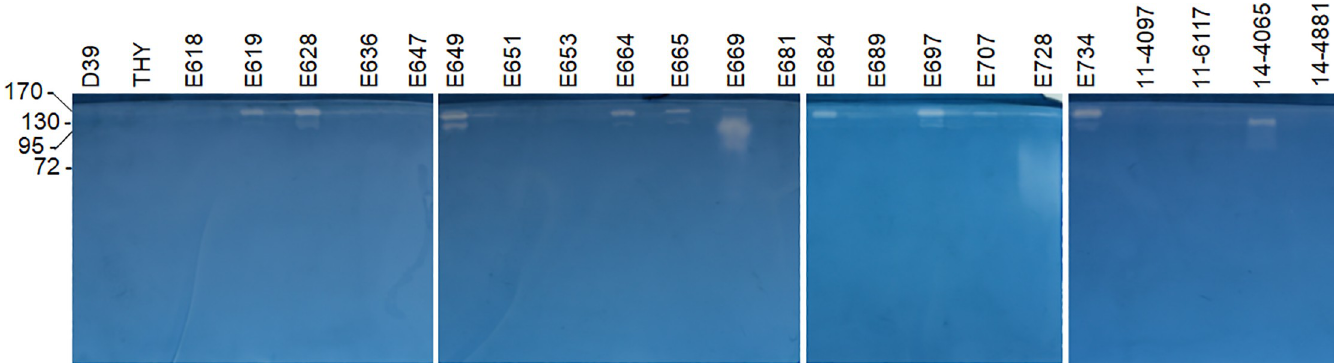
Fig 3. Gelatin zymography of VGS supernatants and controls. Each concentration-normalized sample was subjected to zymography to detect protease activity. Zones of clearing indicate protease activity. Molecular mass standards in kDa are indicated to the left of the gels. Two independent experiments were performed, yielding the same results. Shown are zymograms from one set of biological replicates. Each set of biological replicates was electrophoresed simultaneously using 4 zymogram gels with a lane space between each sample.